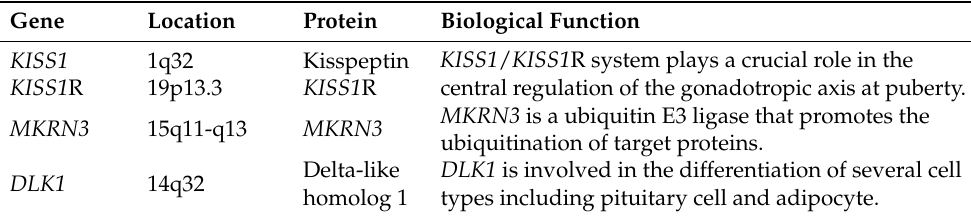
Table 1. Known pathogenic genes associated with central precocious puberty. Gene Location Protein Biological Function KISS1 1q32 Kisspeptin KISS1 / KISS1 R system plays a crucial role in the central regulation of the gonadotropic axis at puberty. KISS1 R 19p13.3 KISS1 R MKRN3 is a ubiquitin E3 ligase that promotes the MKRN3 15q11-q13 MKRN3 ubiquitination of target proteins. DLK1 is involved in the differentiation of several cell Delta-like DLK1 14q32 homolog 1 types including pituitary cell and